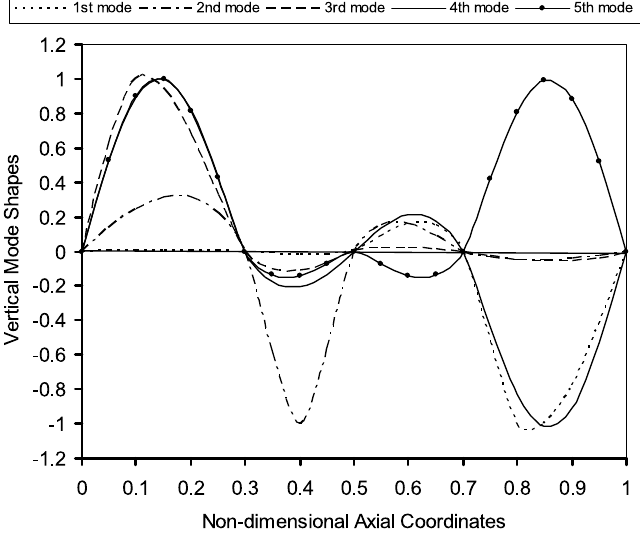
Fig. 10. The fi rst fi ve mode shapes for the model with three spring-mass systems of four-span Reddy-Bickford beam. Reddy-Bickford and Timoshenko